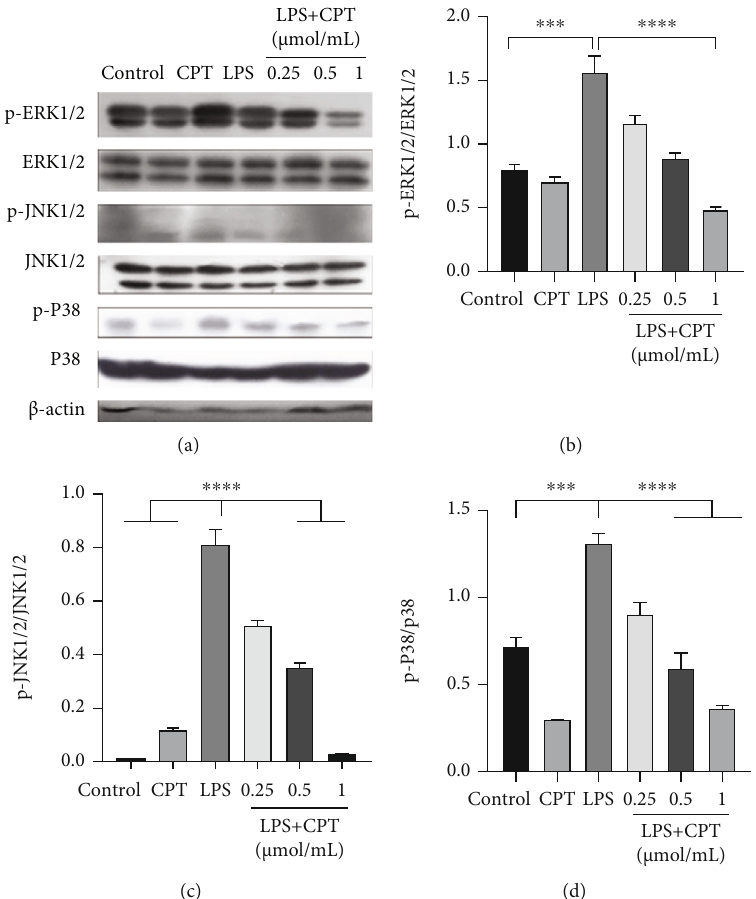
Figure 8: E ff ects of camptothecin (CPT) on LPS-induced activation of the MAPK signaling pathway in RAW264.7 cells. Total protein in RAW264.7 cells was collected after 4h of LPS stimulation. CPT was added 1h before LPS stimulation. Protein levels of (a, b) p-ERK1/2, (a, c) p-JNK1/2, and (a, d) p-P38 were detected by western blot and quantitatively assessed via densitometry using ERK1/2, JNK1/2, and P38 as internal controls. Protein levels were measured using ImageJ (http://imagej.nih.gov/ij/) and normalized to the protein levels of ERK1/2, JNK1/2, and P38. Values are presented as mean ± SD ( ∗∗ P < 0 : 01 vs. LPS, ∗∗∗∗ P < 0 : 0001 vs.